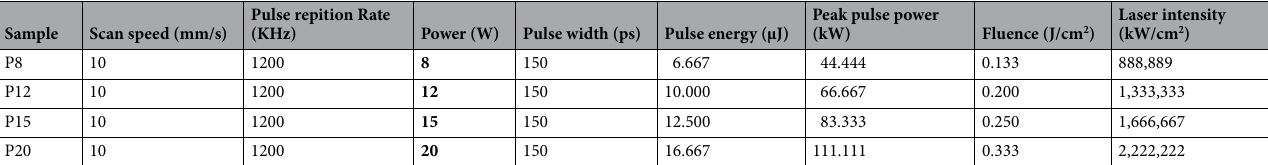
Table 1. Laser parameters for different samples. Significant values are in